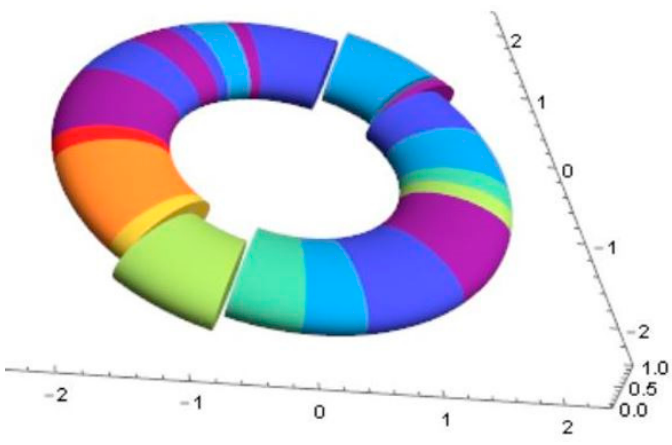
Figure 1. Torus Antipodal Strings. World lines with matching description preserve the nearness of pairs of sets. See text for further details.